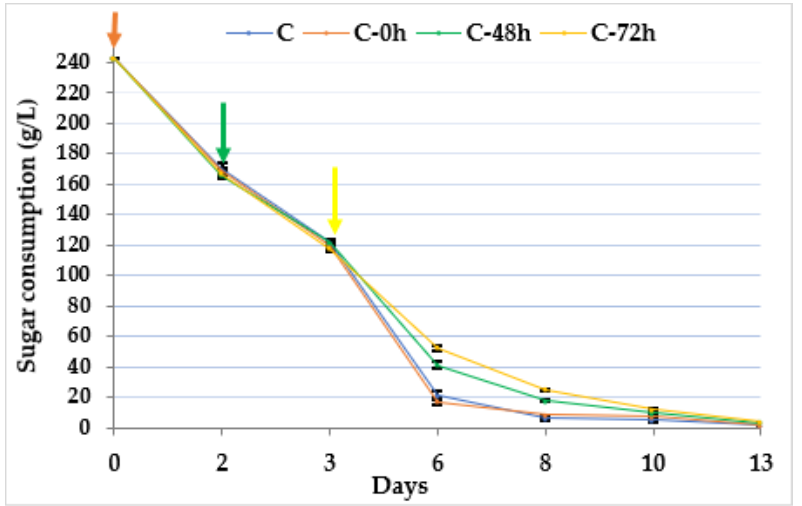
Figure 6. Kinetics of sugar consumption in single starter fermentation with EC1118 strain in grape must added with acetic acid at different times. C—control fermentation, without acetic acid addition; C-0 h—addition at the beginning of the fermentation process; C-48 h—addition 48 h after inoculum and C-72 h—addition 72 h after inoculum. The time of acetic acid addition is shown by the arrow in the graph. Data are expressed as mean value ± SD of three independent experiments.